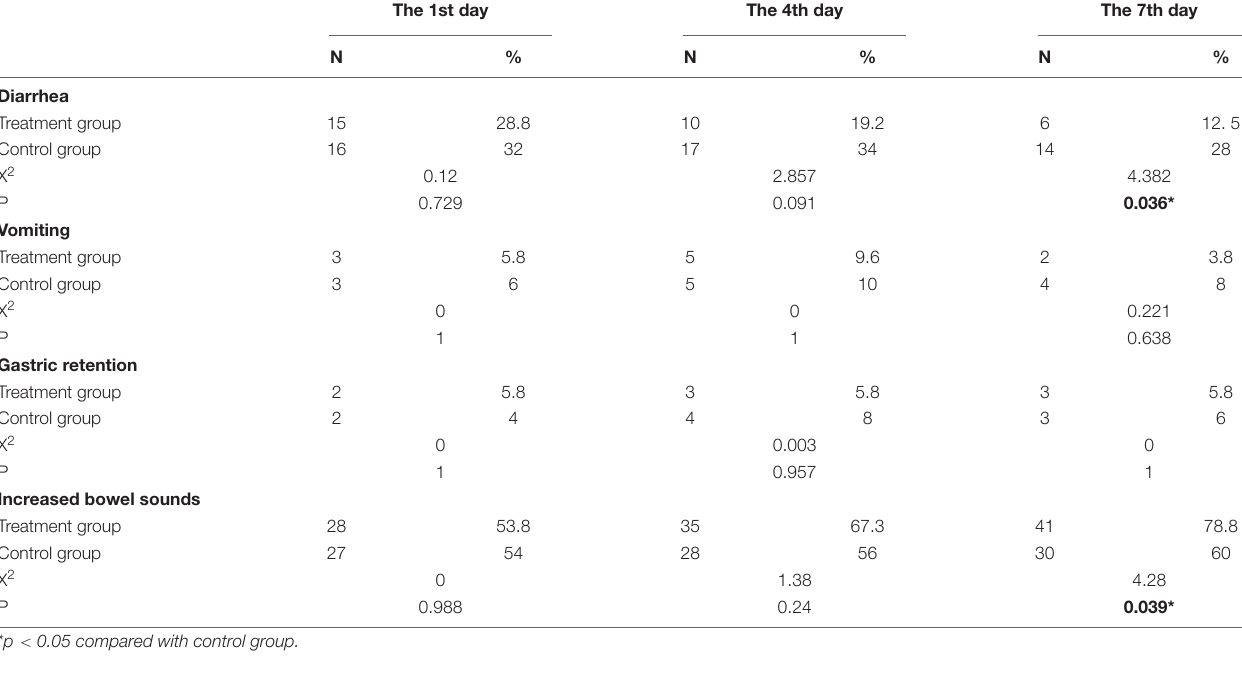
TABLE 3 | Gastrointestinal functions of patients in control and treatment group.